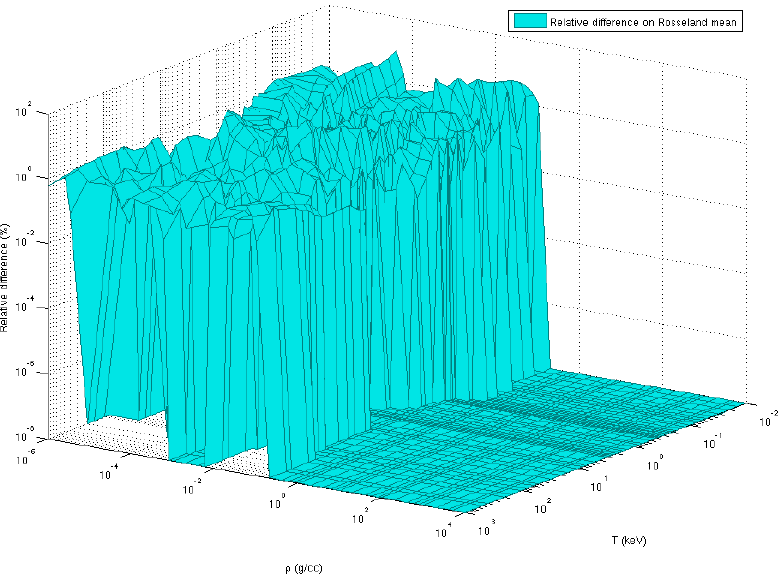
Figure 23. Maximum value of the relative difference (in absolute values) between the iron Rosseland mean opacities of a calculation with a maximum number of 1000 superconfigurations and a maximum number of 10,000 superconfigurations as a function of temperature and